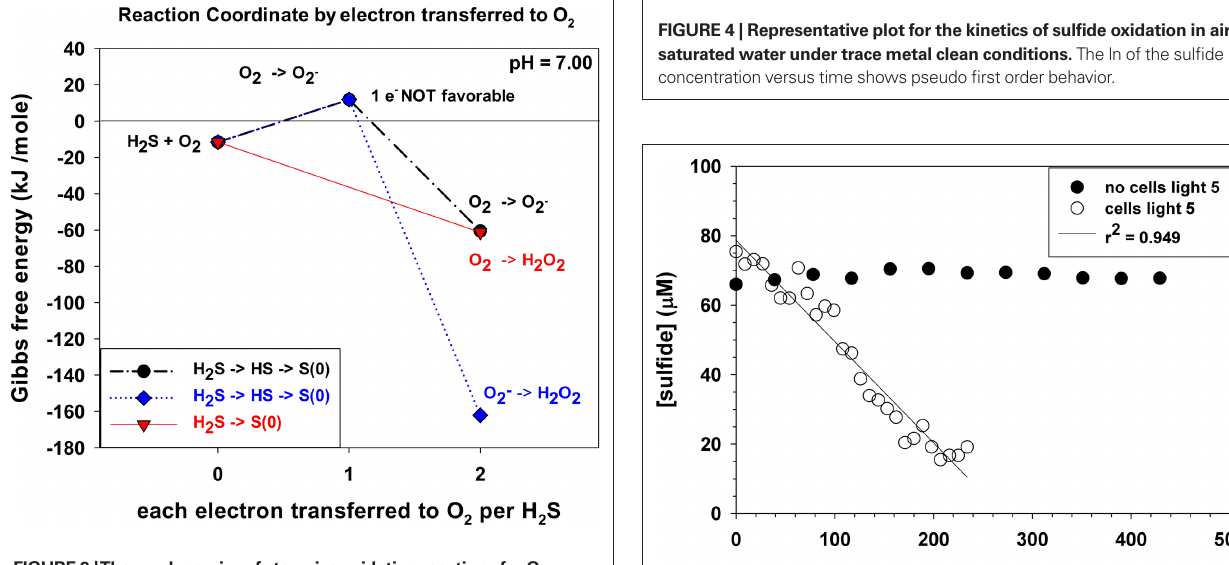
Figure 3 | Thermodynamics of stepwise oxidation reactions for O oxidation with H S for both one and two-electron transfer reactions. At 2 zero electrons transferred, ∆ G o is the sum of the standard state ∆ G o values before a reaction occurs.